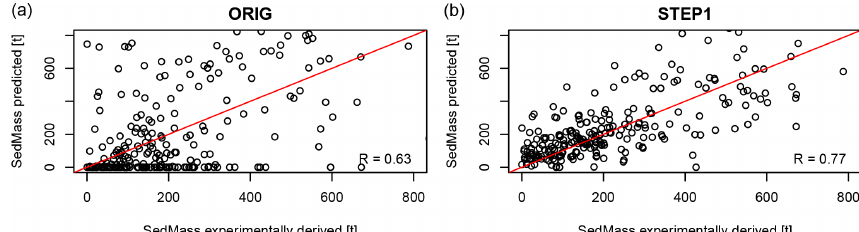
Figure 5. Sediment mass simulated by EROSION-3D with the experimentally derived skinfactor versus skinfactor predicted by the ORIG model (a) and STEP1 model (b) .